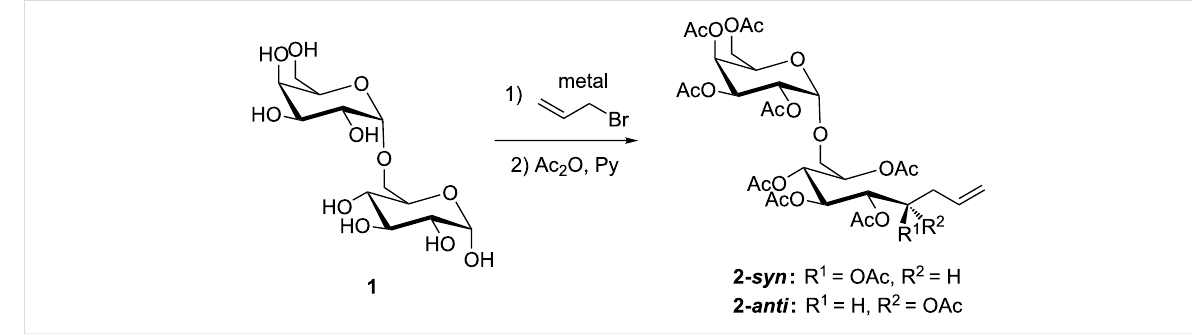
Scheme 1: Indium-mediated allylation of melibiose ( 1 ).